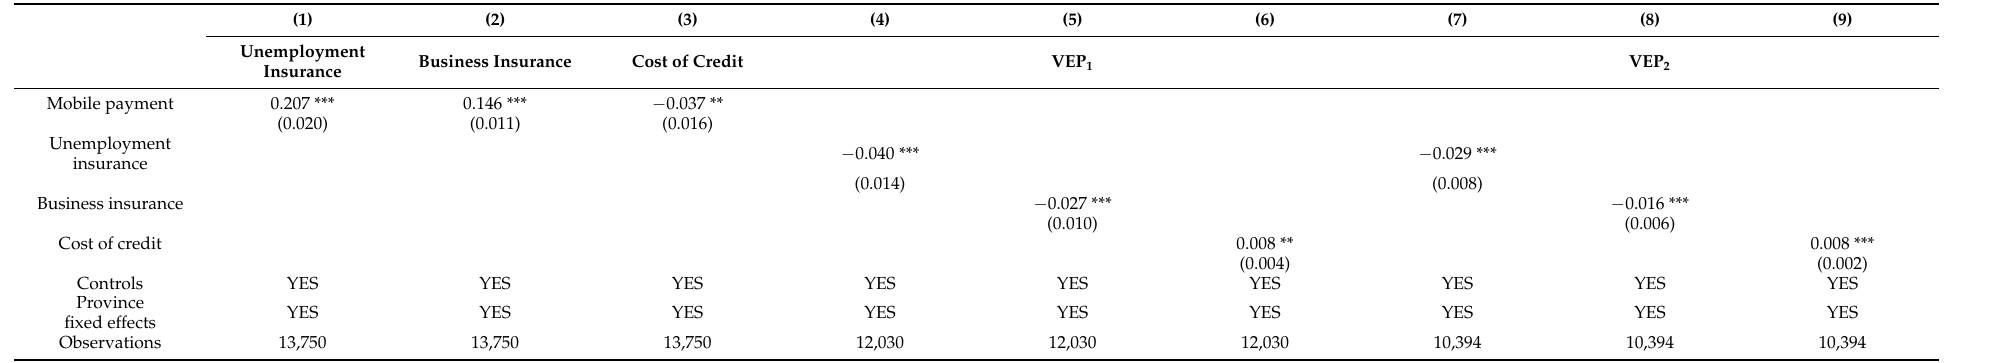
Table 7. The results of the risk management capacity mechanism